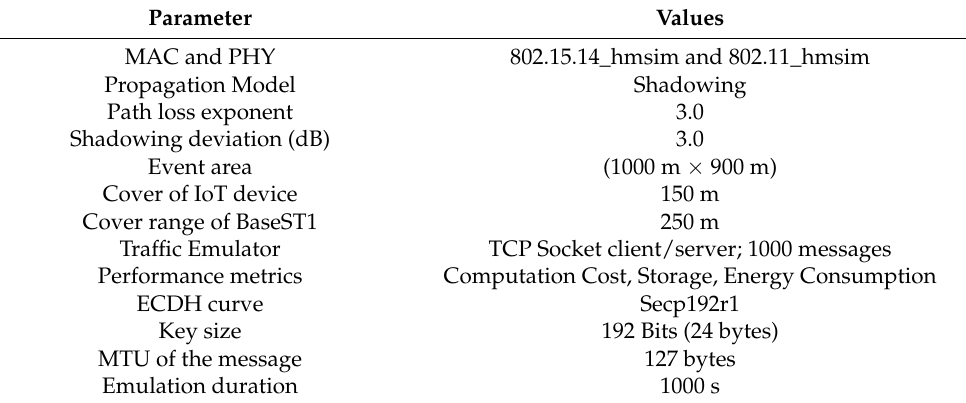
Figure 3. IoT mesh topology and ESSC implementation. Table 3. Experiment